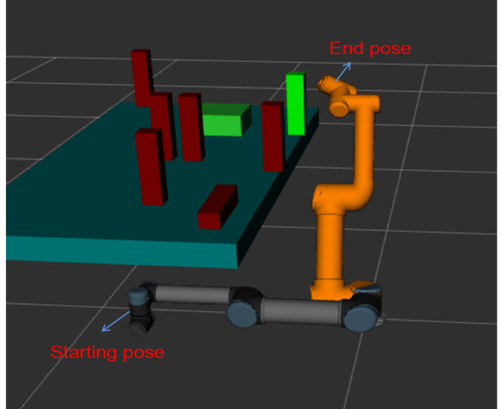
Figure 12. The poses of the start and end points of the UR5.